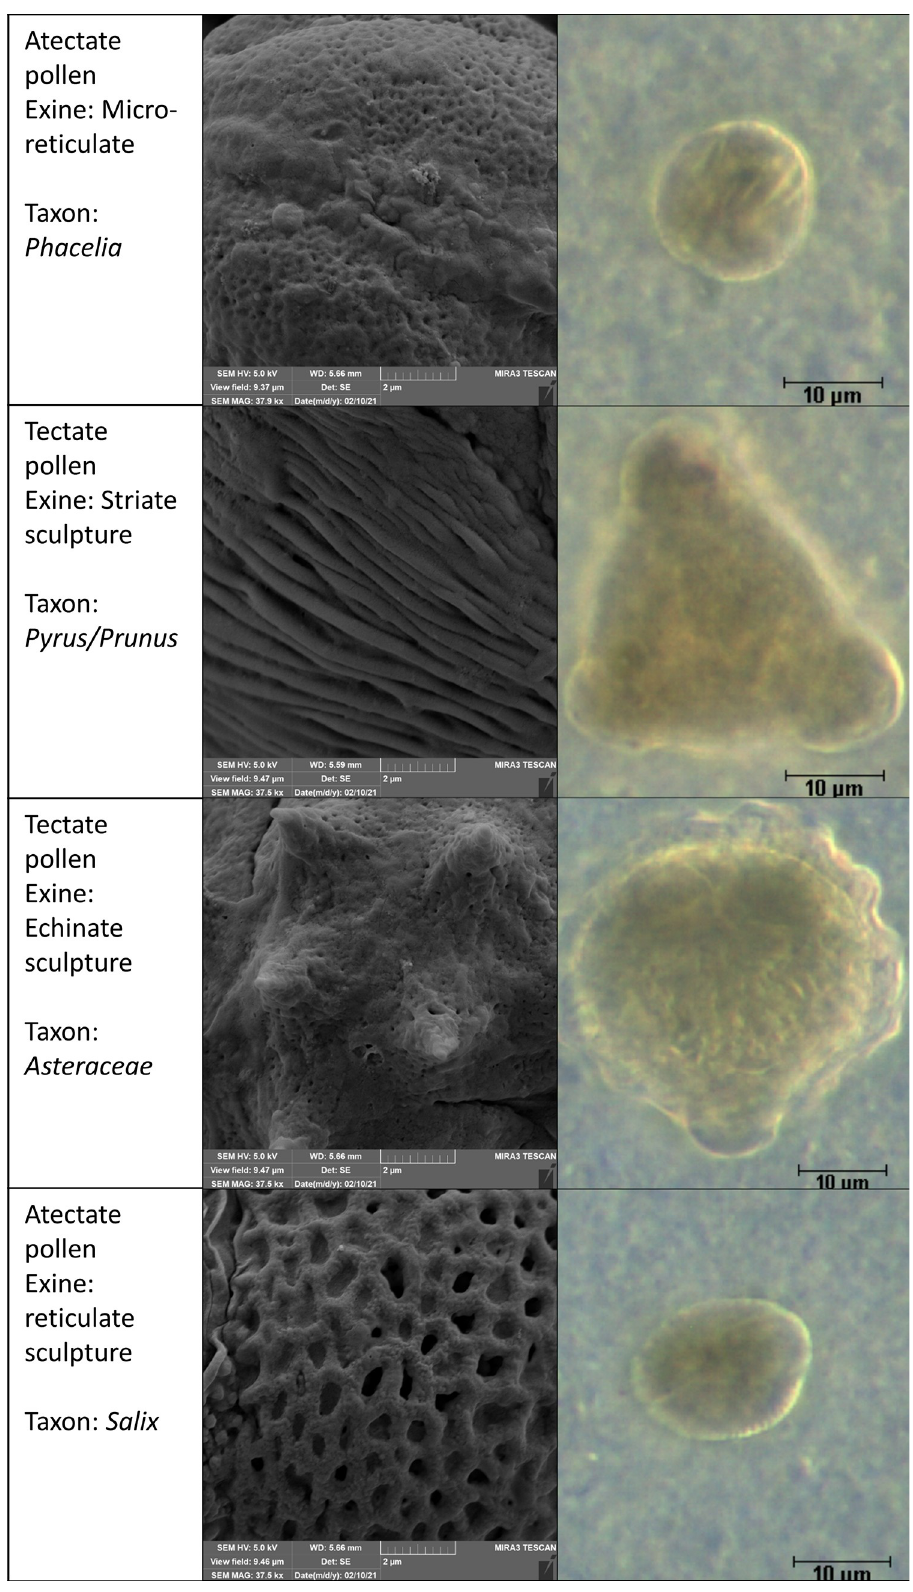
Fig 3. Typical exine sculptures of the botanical taxa studied, left–SEM, right–DF.